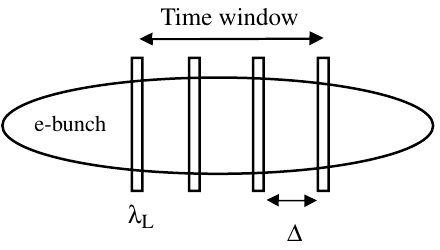
FIG. 10. Slicing of the e bunch for time dependent